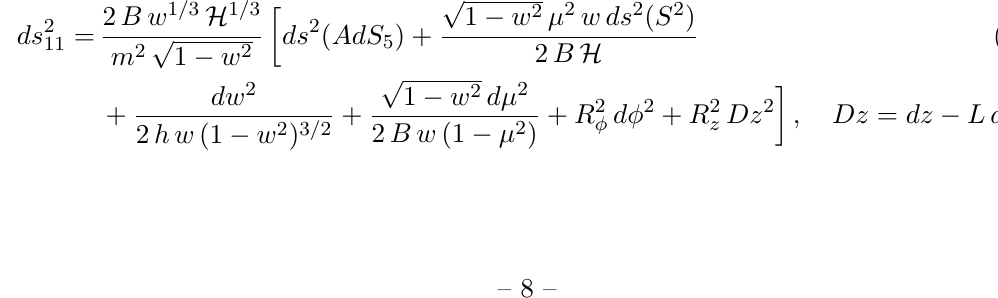
× S 1 × S 2 fibration over the rectangle z φ , P , P , P . We indicate the constant value of the 1 2 3 4 and P . The point P 2 P 3 3 P 4